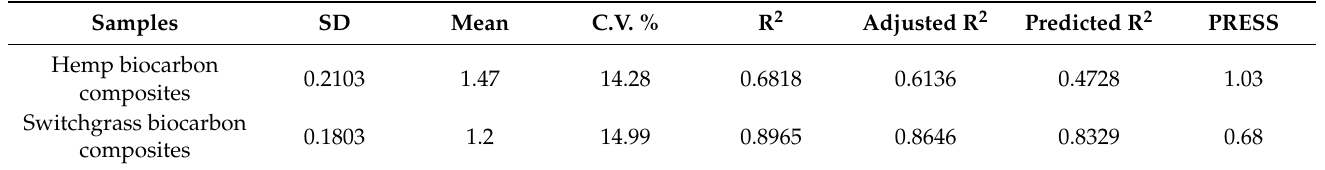
Table 5. Fit Statistics (the predicted R 2 against the adjusted R 2 ) for the Reduced Model of the Biocarbon-Filled Hemp Composite